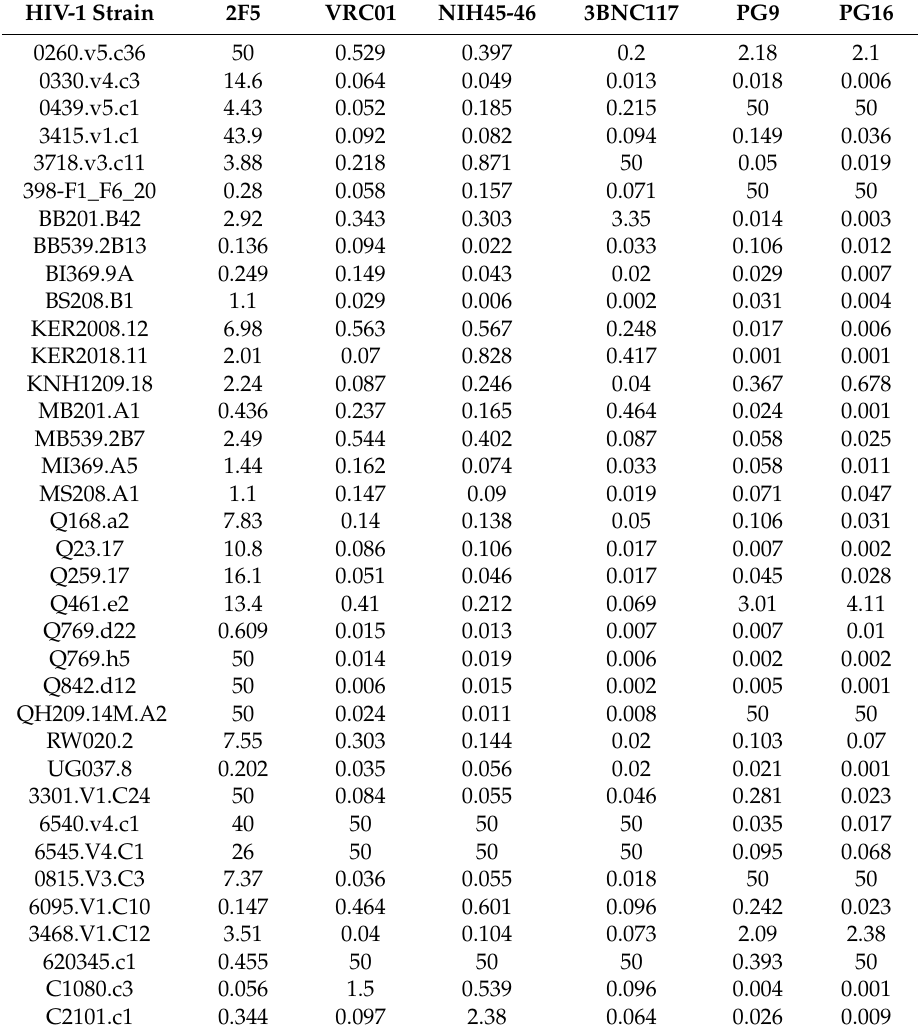
Table 1. Sample data used for training the network (HIV-1 strains in the first column, neutralization data for six selected antibodies in the other